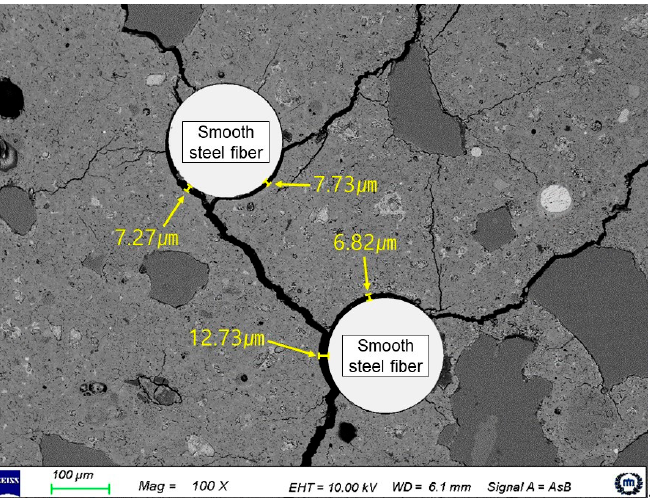
Figure 10. Interfacial gap between the matrix and SSF by the micro split cracks at high strain rates (HP-HFRCC).